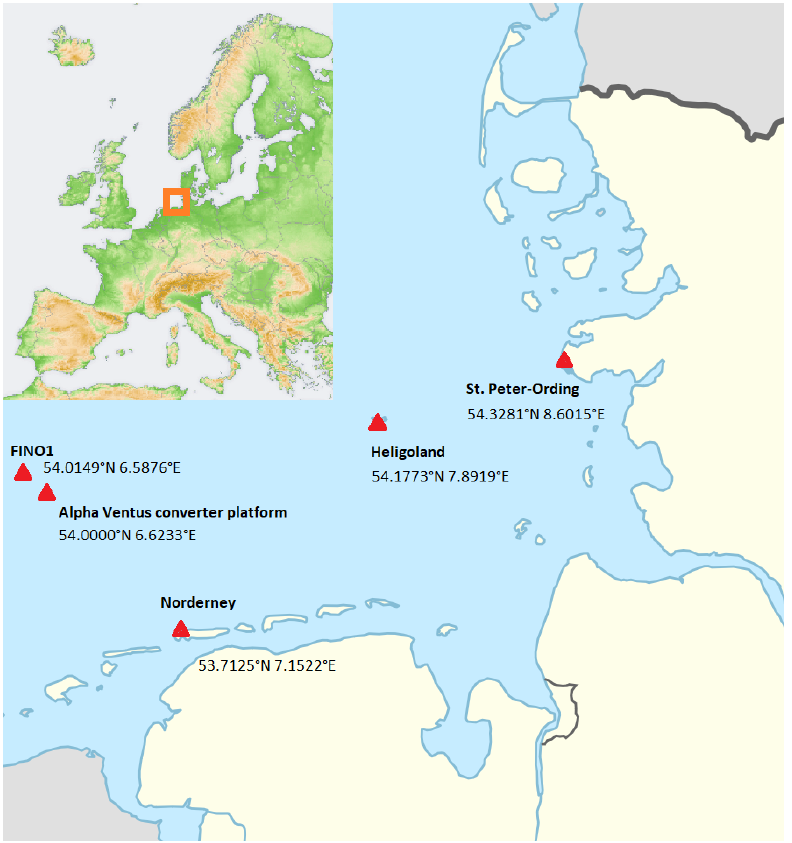
Figure 1. Location of measurement sites of the lidars (St. Peter-Ording, Heligoland, FINO1, Alpha- Ventus, Norderney)